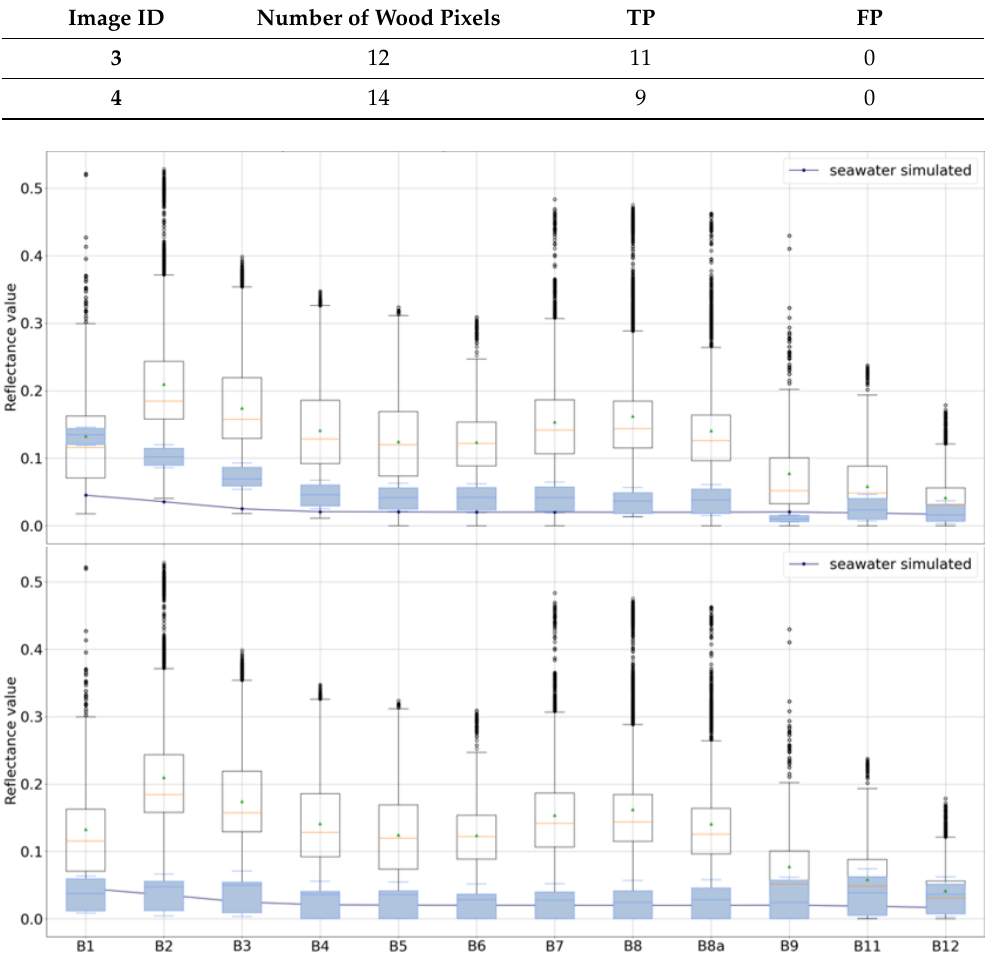
Figure 12. Boxplots of the simulated plastic values and real seawater values. For both figures, the transparent boxplots contain simulated plastic values taken from our dataset and the averaged spectral signature of simulated water, the dark blue line. For both figures, the blue boxplots contain real seawater values. On the top, the real seawater values are collected from image 1 and from the image of the 11 June (600 seawater pixels). On the bottom, the real seawater values are collected from image 2, 3, and 4 (1200